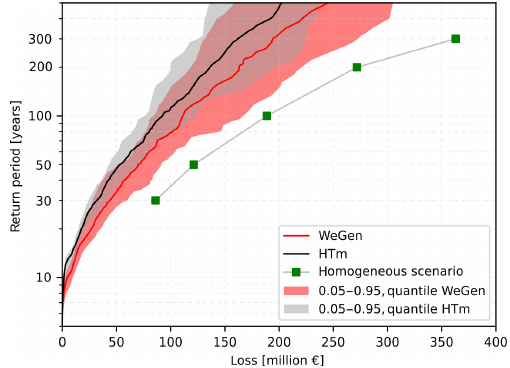
Figure 6. Risk curves for WeGen and HT-model approach in com- parison to the results of a homogeneous scenario. The median and quantile confidence intervals are based on 30 realisations of 1000 years of simulation. Monetary values are normalised to the year